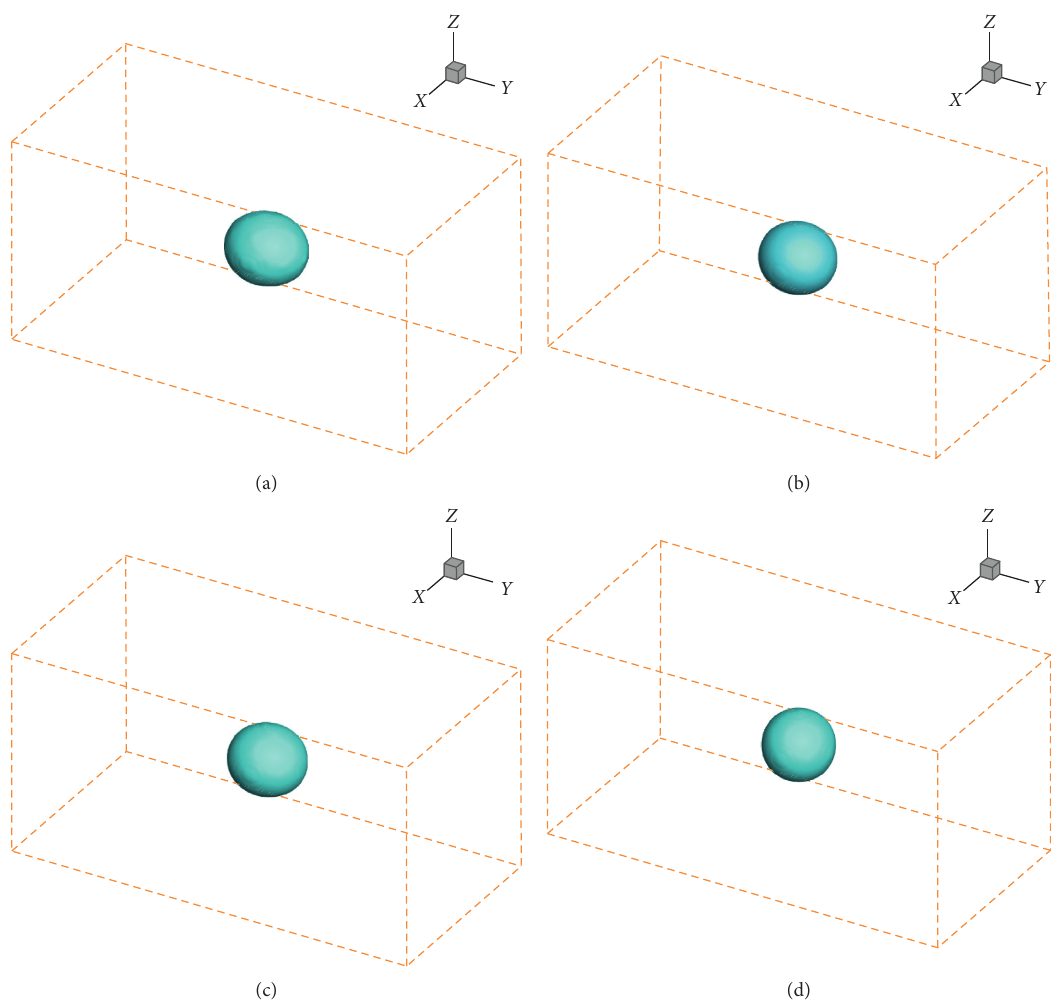
Figure 4: Drop shapes during the retraction process in case of De � 0 with various deformability: (a) 0.15; (b) 0.12; (c) 0.06; (d) 0.